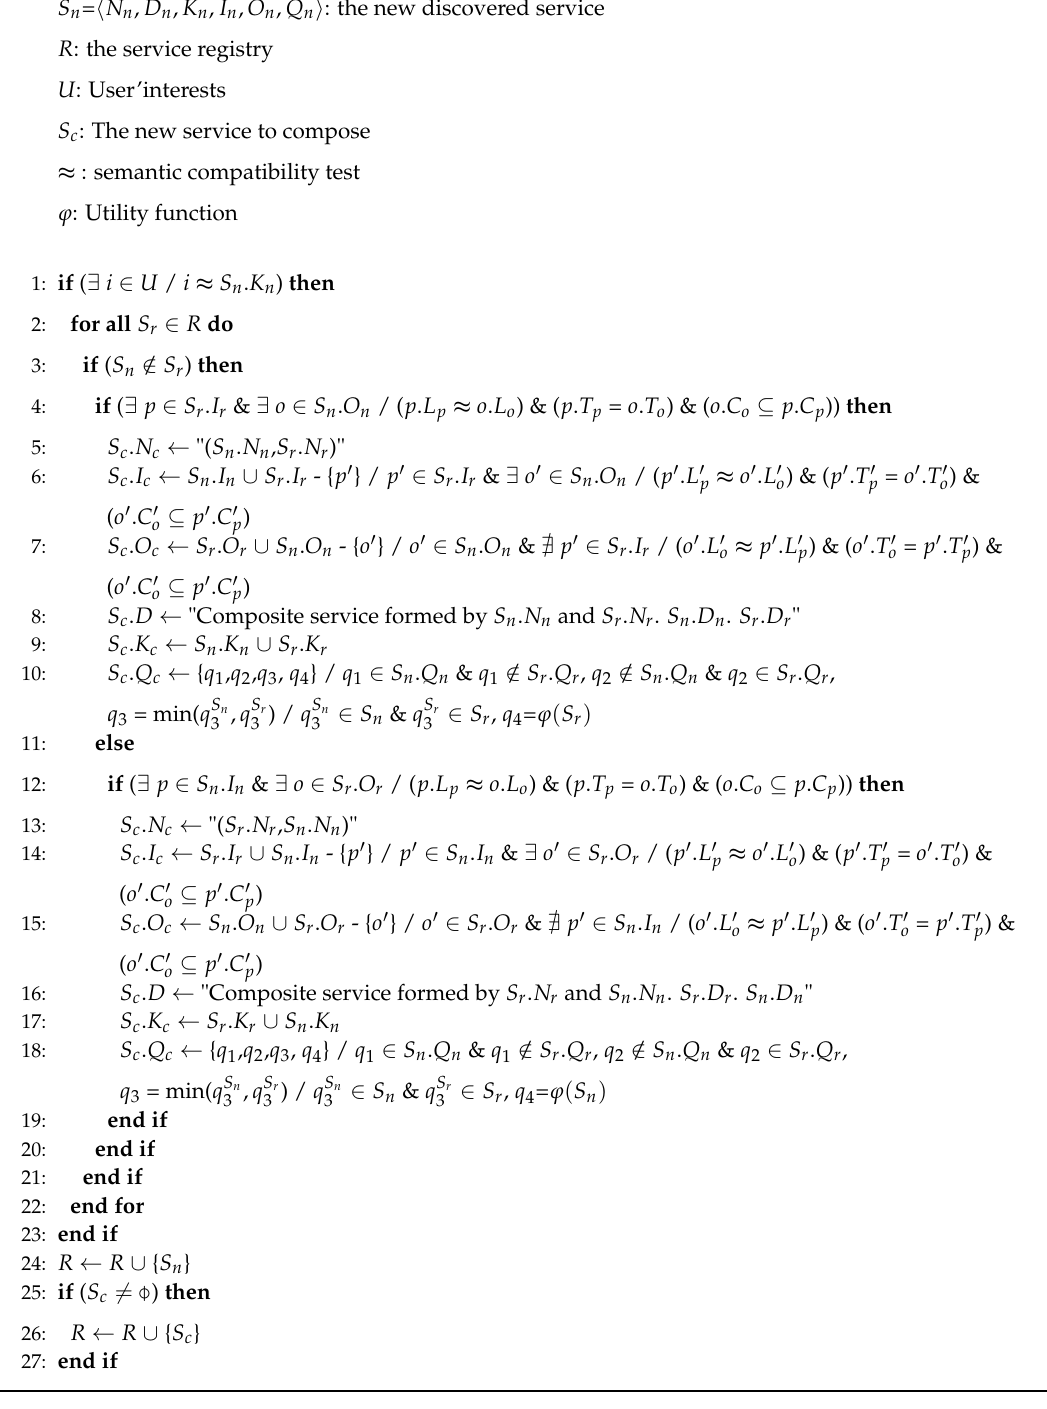
Algorithm 1: Algorithm triggering service composition upon discovery of new